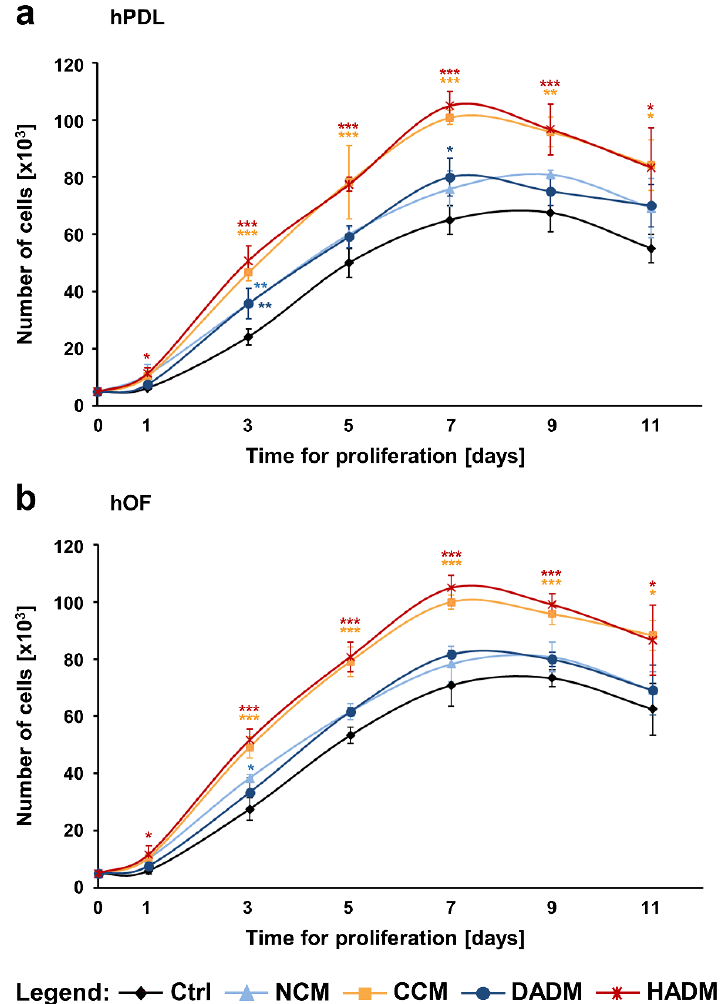
Figure 3. Proliferation rates of primary hPDL ( a ) and hOF ( b ) cultured on tissue culture plastic (Ctrl) or on each of the four collagen matrices (NCM, CCM, DADM, and HADM) were assessed by trypan blue dye exclusion cell counting. The number of viable cells in each experimental group was determined on day 1, 3, 5, 7, 9, and 11. Data represent means ± SD from three independent experiments performed with three di ff erent cell donors for each of the two cell types. Significant di ff erences to control cells at each individual time point, *** p < 0.001, ** p < 0.01, * p <